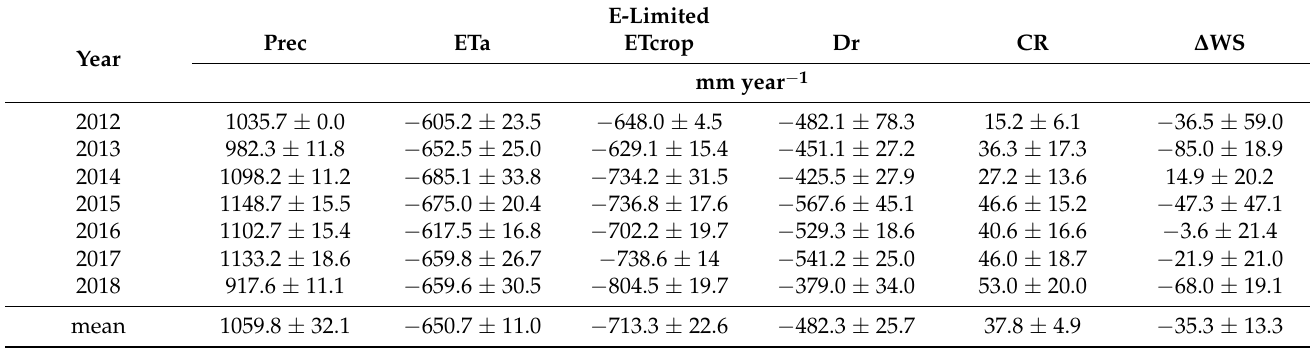
Table A2. Components of the lysimeter annual soil water balance—mean values and standard deviations, ± , in mm year − 1 — for Rollesbroich soil in Rollesbroich, the energy-limited site (E-limited) between 2012 and 2018 with the precipitation (Prec), actual evapotranspiration (ETa), crop-height-adjusted reference evapotranspiration (ETcrop), drainage (Dr), capillary rise of water (CR), and change in soil water storage ( ∆ WS); negative values represent a loss of water for the system; row “mean” gives the means of the annual values for the period 2012–2018; the inter-annual variability is represented by the standard error of the annual mean